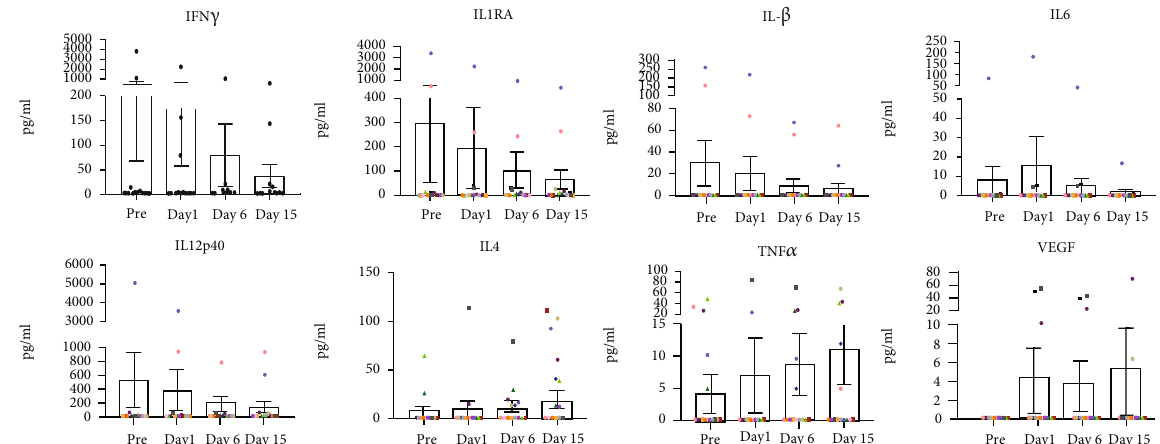
Figure 6: Cytokine multiplex assays. In duplicate wells of the 96-well fi lter plate, 25 μ L of cell supernatant was incubated with 25 μ L of cytokine-coupled beads overnight at 4 ° C, followed by washing and staining with biotinylated detection antibody. The plates were read on a Luminex 200 analyzer, and the results are expressed as pg/mL concentration. The minimum detectable concentrations in pg/mL for IFN γ (2.2), IL1RA (2.4), IL1 β (1.2), IL6 (0.3), IL12 (P40) (1.2), IL4 (2.7), TNF α (2.1), and VEGF (13.6) were used for considering positive responses. See Materials and Methods for experimental details. p values were considered statistically signi fi cant at p < 0 : 05 ( F ð 3 : 27 Þ = 14 : 01 , p < 0 : 001 , partial η 2 = 0 : 609 ), and LPS